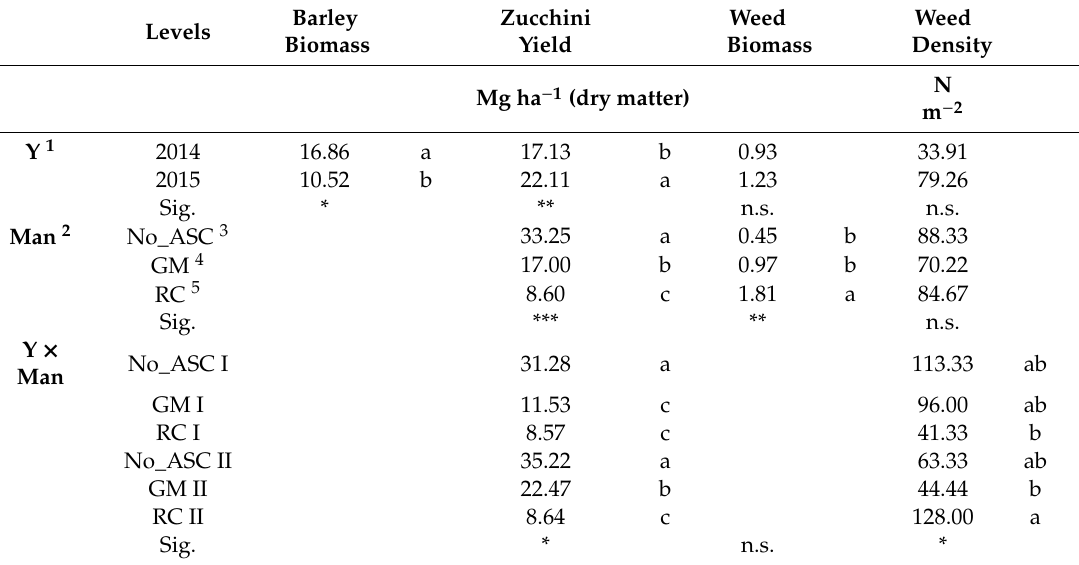
Table 1. Barley biomass, zucchini marketable yield, and weed density and biomass, 2014–2015. Barley Levels Biomass